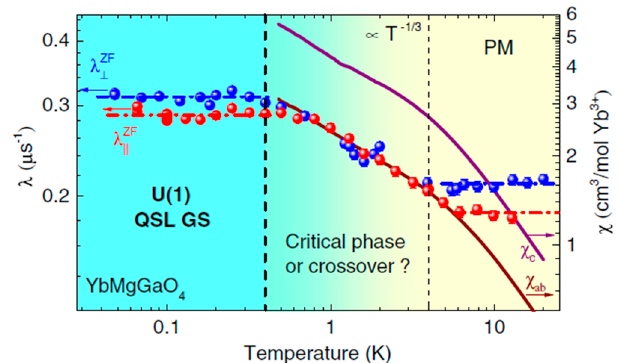
Figure 10. Temperature dependence of the muon spin relaxation rates from zero field measurements and from the bulk static susceptibilities measured in an applied field of 0.01 T for YbMgGaO 4